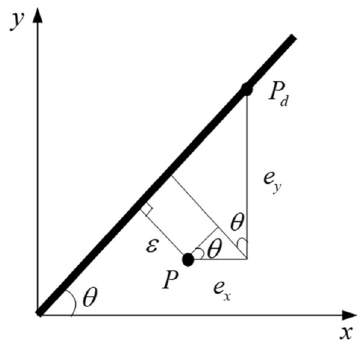
Figure 2. Error model of the straight-line